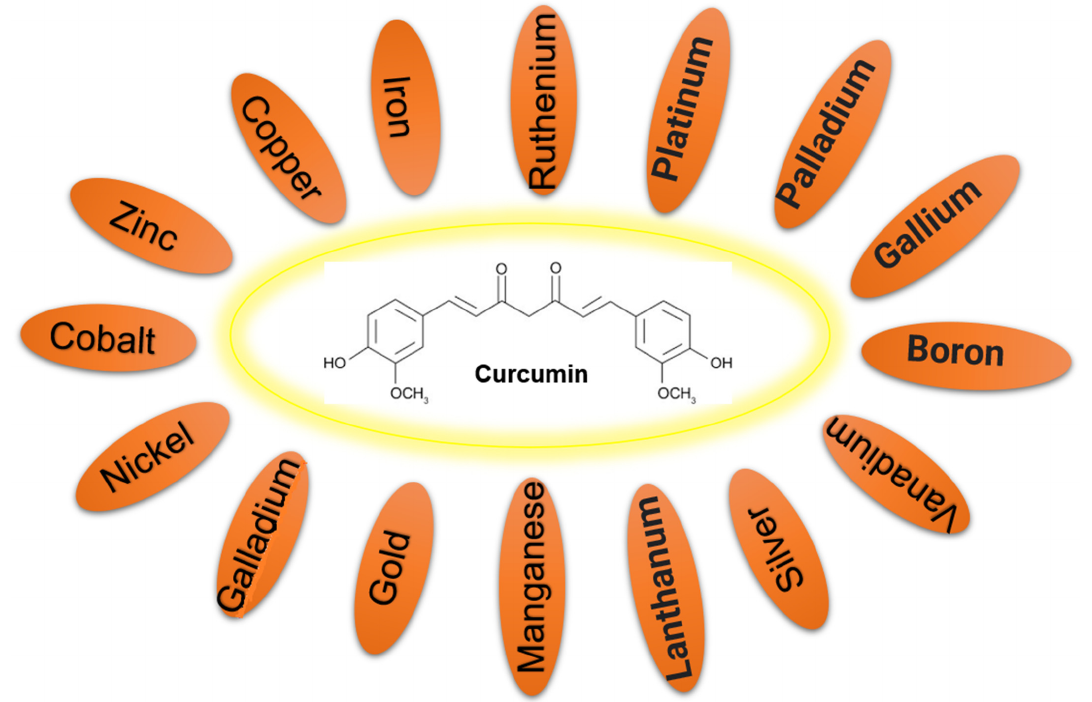
Figure 2. Curcumin interacts with various metals and forms metal–curcumin complex.